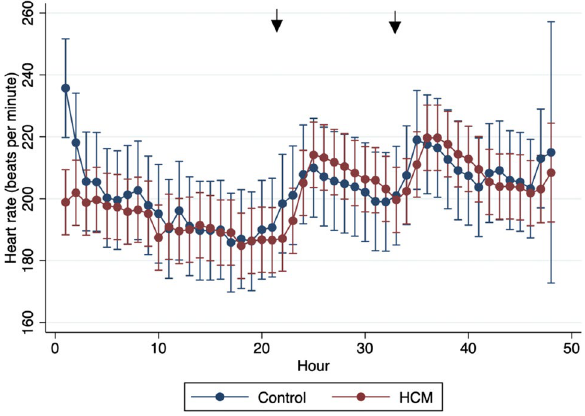
Figure 1. Mean heart rate (HR) plotted by hour for the entire AECG recordings separated by phenotype (subclinical HCM vs. control group). Arrows indicate when terbutaline was administered.